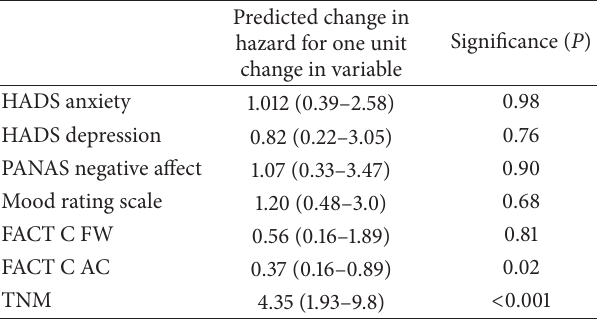
Table 6: Multivariate analysis of postoperative Qol and survival with TNM stage as